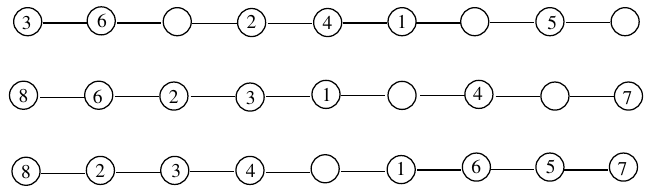
Figure 1: Three minimal irregular dominating sets of P